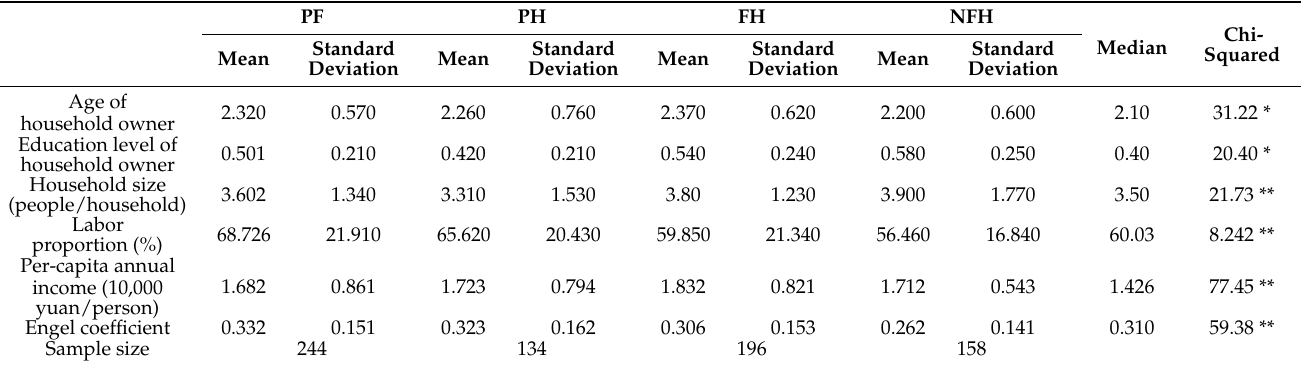
Table 1. Descriptive indicators of the four production